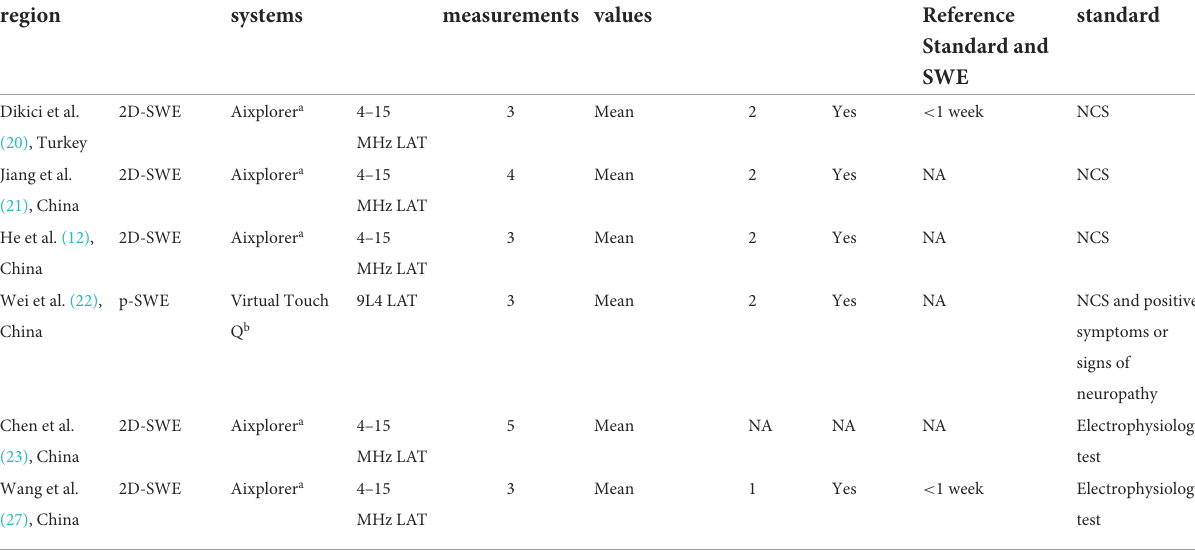
TABLE 2 Technical characteristics of the elastography/reference standard used in the included studies.